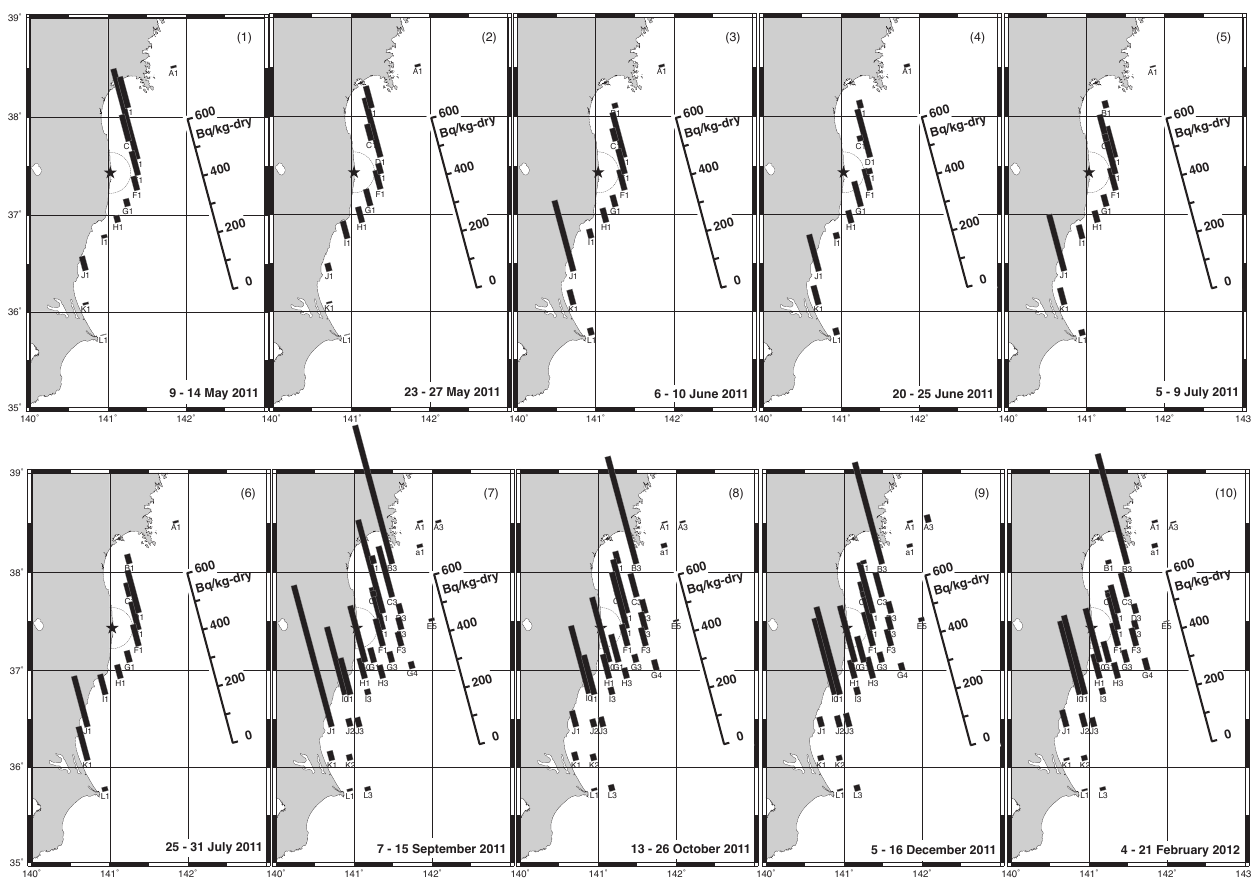
Fig. 3. Spatiotemporal distribution of 137 Cs concentrations in sediment samples collected on the dates indicated in the panels. Six sediment samples were collected at Stn. D1 on 13 September 2011, and the average value for the six samples is plotted in the figure (see Sect. 3.1 and Fig.